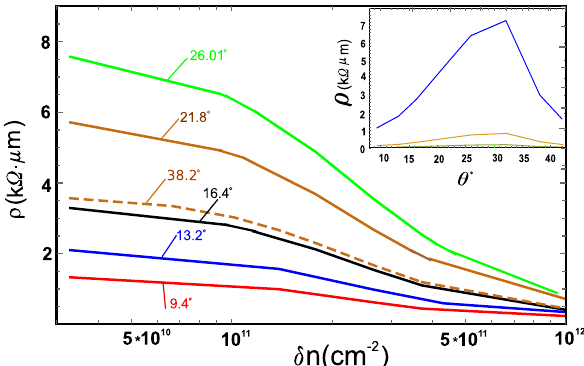
300 K for different misorientation angles: = 13 eV, effective = 8 2 0.2 . The screening radius R has greatest value cm − , (cid:31) =60 ◦ , ζ =